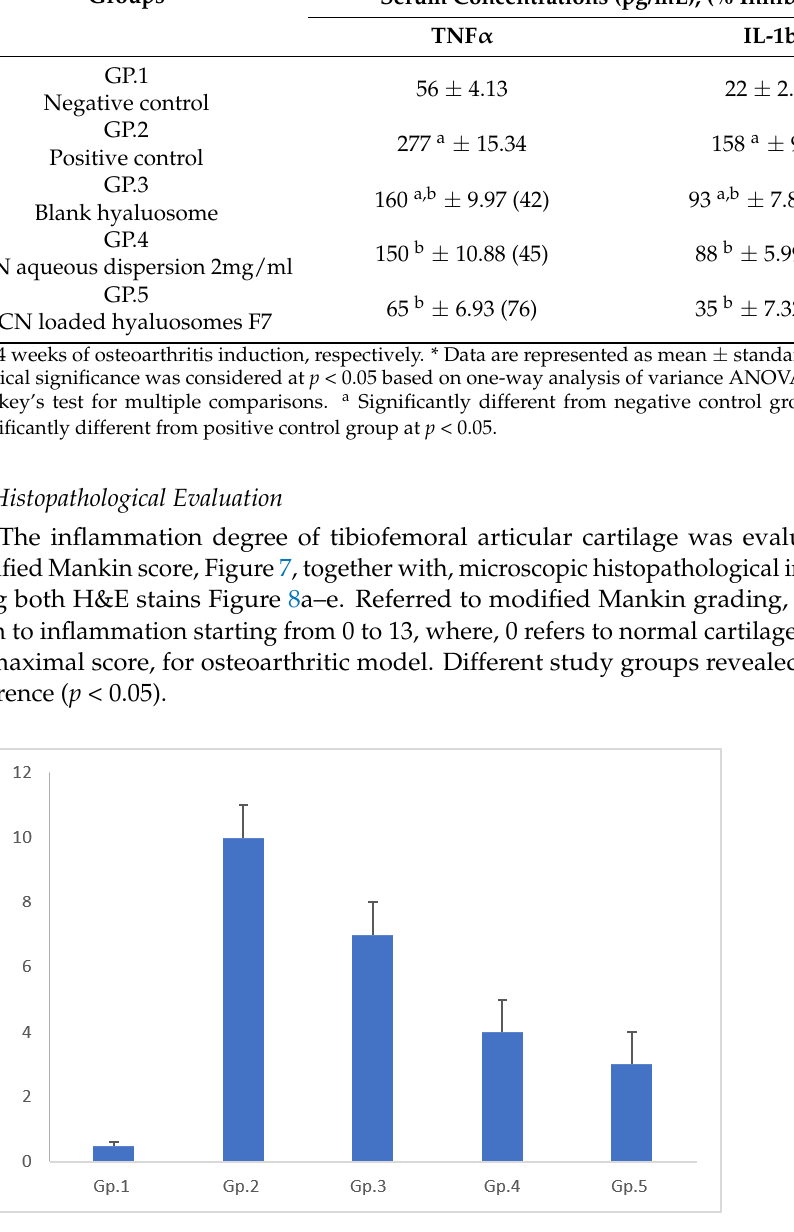
Figure 7. Morphological assessment of articular cartilage of different study groups: GP1 (negative control), GP2 (positive control), GP3 (Blank hyaluosome), GP4 (DCN aqueous dispersion), and GP5 (optimized DCN loaded hyaluosomes (F7)) using modified Mankin score.